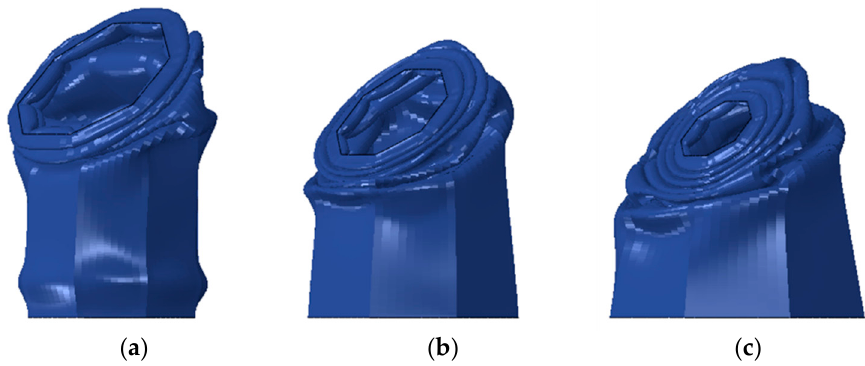
Figure 9. Crushed tubes of panels 4-1-0.6- θ -3 ( a ) θ = 0° ( b ) θ = 5° ( c ) θ = 10°.